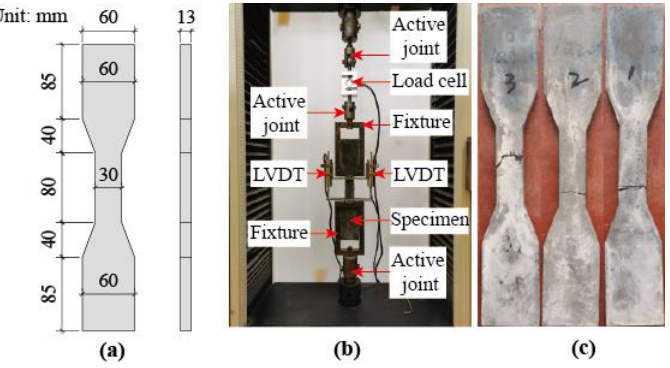
Figure 3. Uniaxial tensile tests of UHPC. ( a ) dimension of specimen; ( b ) test setup; ( c ) tested speci- mens.